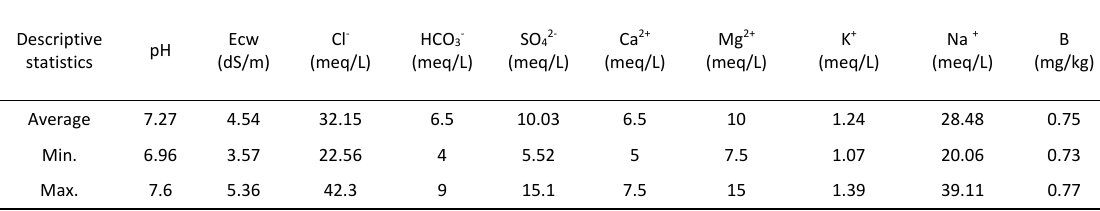
Table 2: Main treated wastewater chemical characteristics